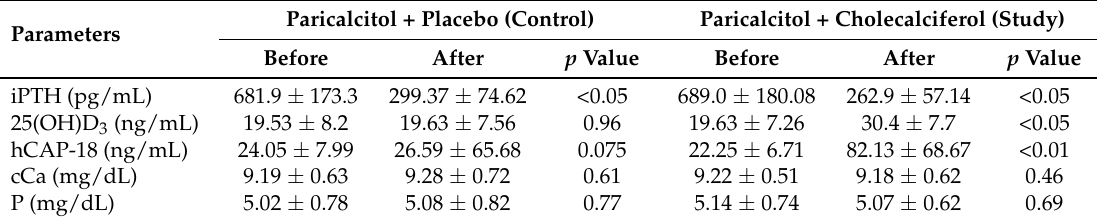
Table 2. Serum biochemistry parameters changes after 16 weeks of